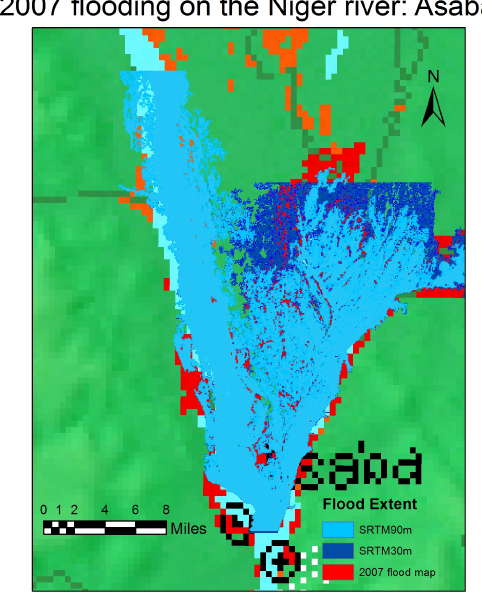
Figure 4. Model simulation result of flooding on the Niger River (2007) using SRTM topographic